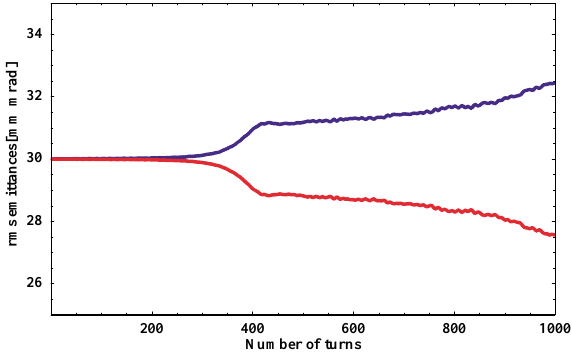
FIG. 12. (Color) Time evolution of rms emittance for (cid:1) n x , n y (cid:2) (cid:1) (cid:1) 5.82, 5.86 (cid:2) . X emittance is shown blue and Y emittance is shown in red.